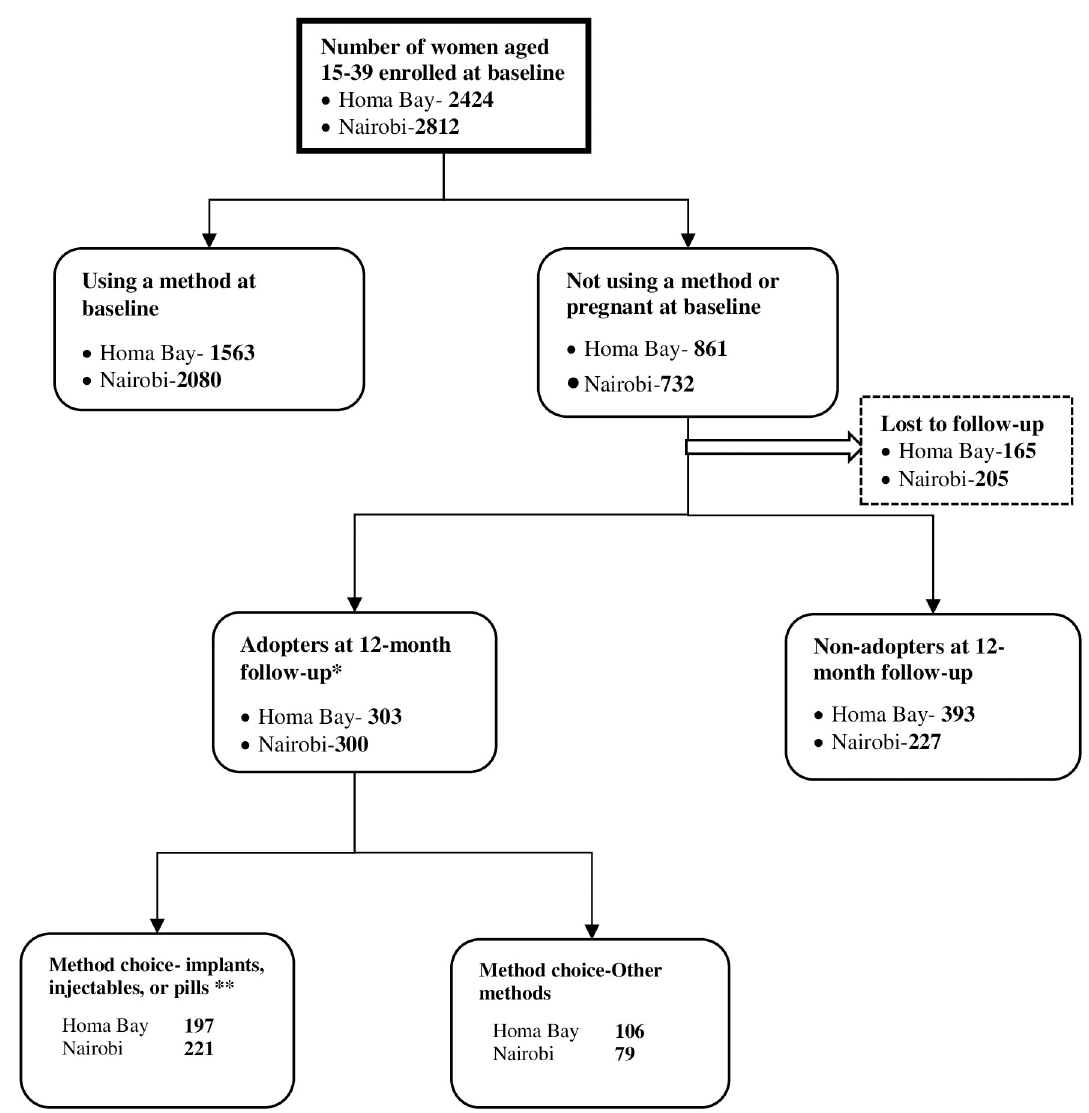
Fig 1. Flow diagram indicating method choice at 12-month follow-up. � Adopters of any method among women who were not using any contraceptive or pregnant but were aware of pills, injectables, and implant at baseline. �� Adopters of pills, injectable or implants among women were not using any method or pregnant but were aware of these three methods at